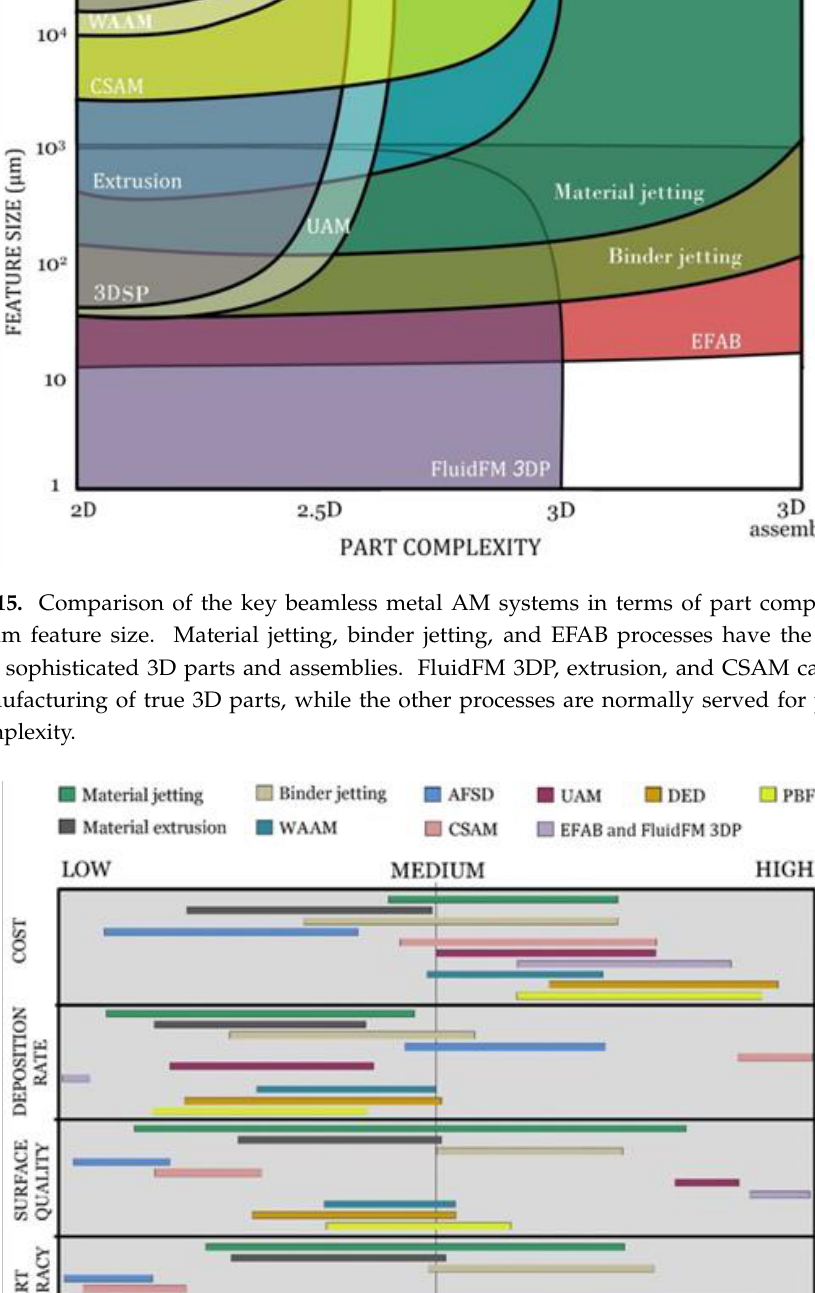
Figure 14. Comparison of the key beamless metal AM systems in terms of part size and productivity. As can be seen, UAM, WAAM, material jetting, extrusion, and FluidFM 3DP are suitable for low-volume production while binder jetting, 3DSP, CSAM, and EFAB have higher deposition rate for high-volume production of metal parts.